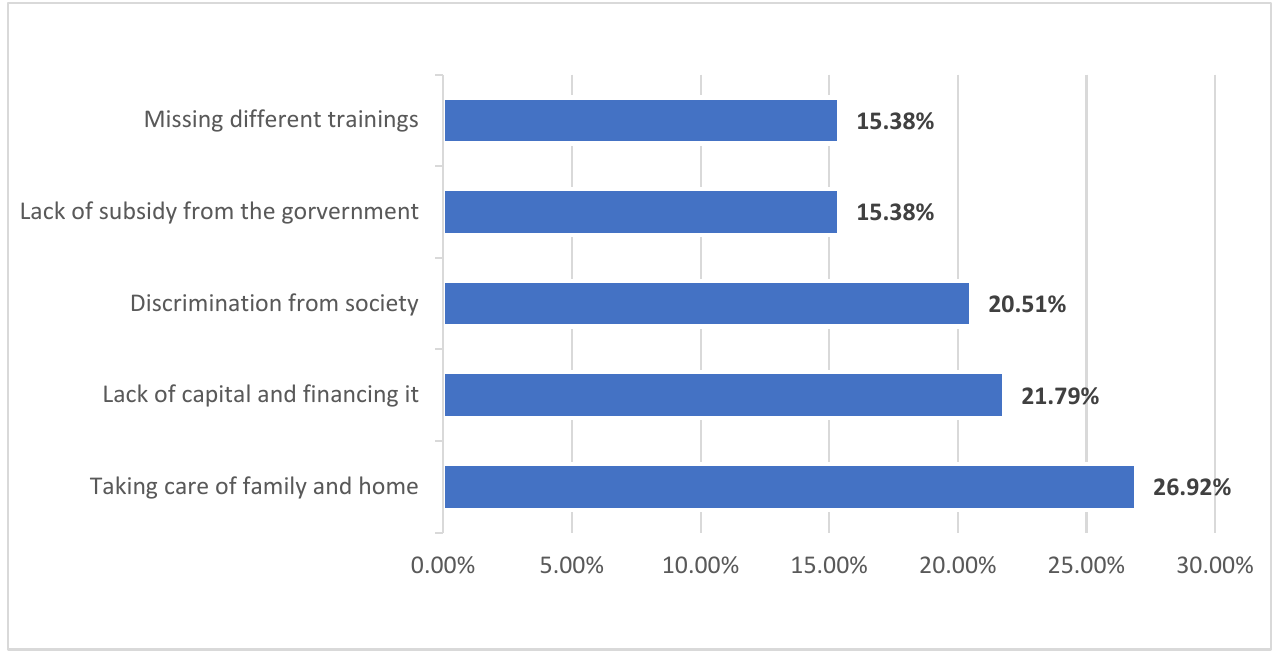
11 of 20 Figure 3. Most discriminatory statements (N = 36). Source: (authors(cid:31) own elaboration). The surveyed females believe that what helps most in establishing and expanding the businesses owned by women is creating an e ff ective network communication between businesses; they believe to be be tt er in terms of establishing good relationships with peo- ple, and thus also business relationships, considering that they are generally more kind, be tt er at public speaking, without foregoing the fact that the majority of businesses are owned by men, and, at speci fi c occasions, are more empathic towards women (Figure 4). Figure 4. Factors a ff ecting businesses performance (N=36). Source: authors(cid:31) own elaboration.